Question: What visual encoding does this figure use to show its data?
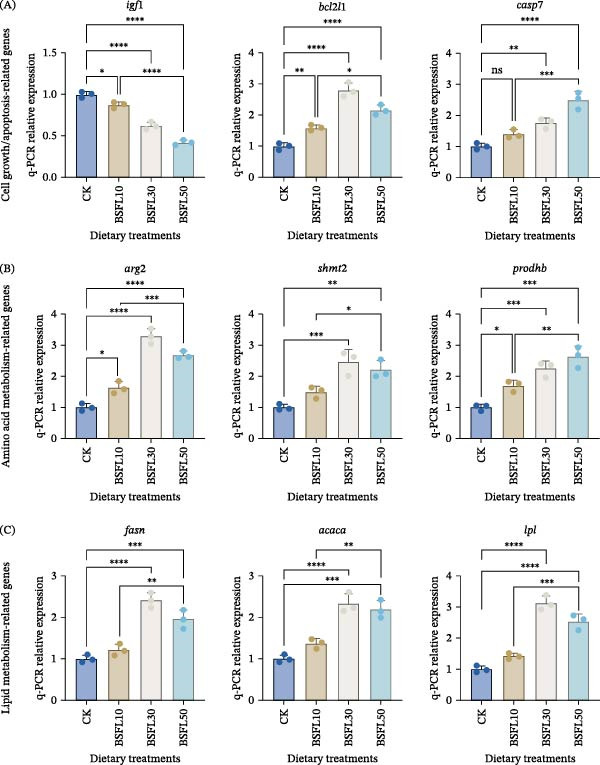
Answer: line